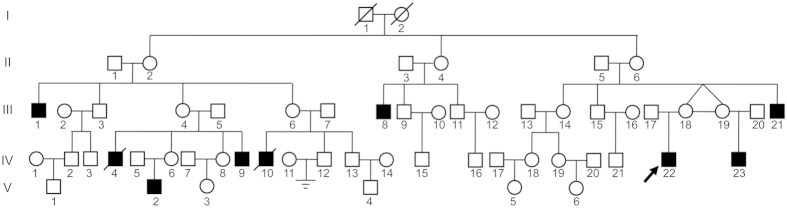
The pedigree of a five-generation Han Chinese family with KS.The men are indicated by squares, and the women are indicated by circles. The symbols marked by a slash indicate that the subject is deceased. Black symbols denote the affected individuals, while the white symbols denote the unaffected individuals. The black arrow denotes the proband.